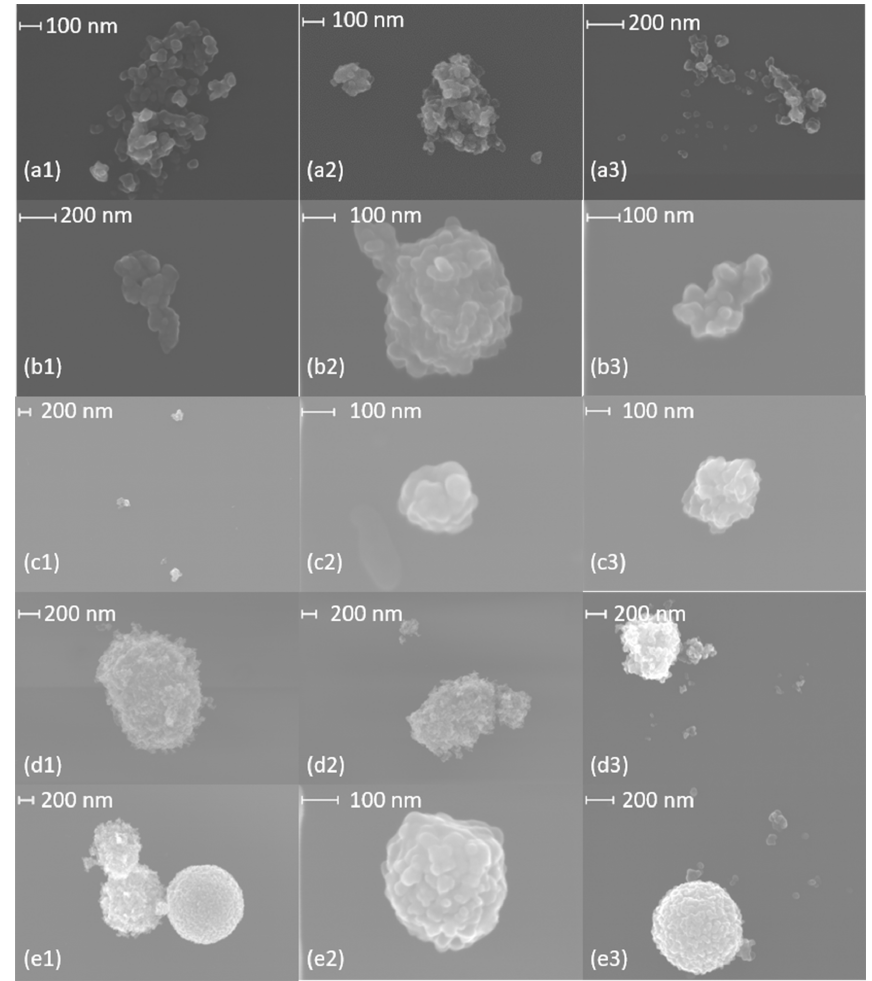
Figure A3. SEM images of (a) 400nm R2500U, (b) 300nm R2500U, (c) 200nm R2500U, (d) 400nm R330R, and (e) 400nm COJ300.